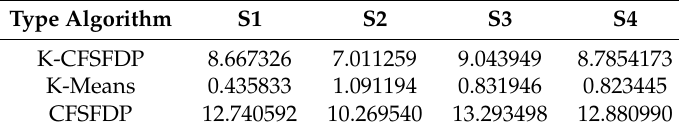
Table 8. Running time(s) of the three algorithms.